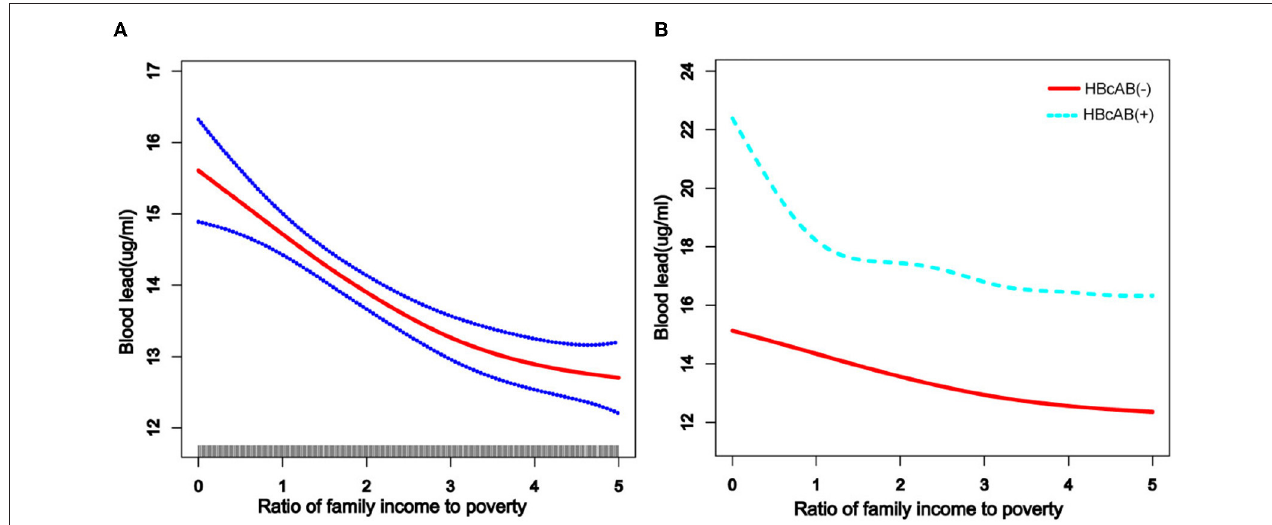
FIGURE 3 | The association between income to poverty (PIR) and blood lead levels. (A) The solid rad line represents the smooth curve fit between variables and a dotted line represents the 95% CI from the fit. All the covariates in the study and HBcAb were adjusted except PIR. (B) The solid rad line represents HBcAb (–) and the dotted line represents HBcAb ( + ). All the covariates in the study are adjusted.